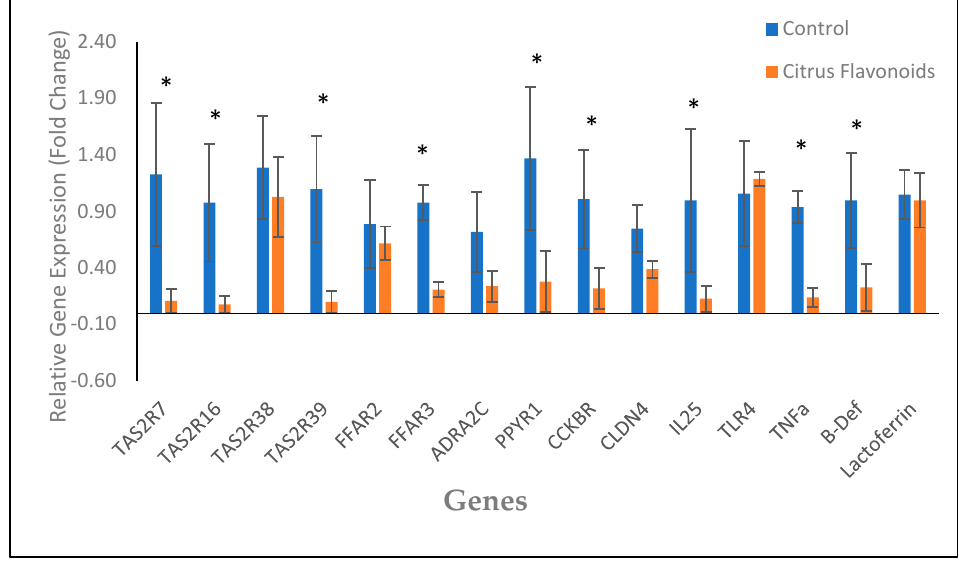
Figure 2. Gene expression in duodenum of Holstein bulls fed high-concentrate diets with or without citrus flavonoids supplementation (* = p < 0.05). TAS2R7: bitter taste receptor 7 ; TAS2R16: bitter taste receptor 16 ; TAS2R38: bitter taste receptor 38 ; TAS2R39: bitter taste receptor 39 ; FFAR2: free fatty acid receptor 3 (gpr41) ; FFAR3: free fatty acid receptor 2 (gpr43) ; ADRA2C: alpha 2 adrenergic receptors subtype C ; PPYR1: pancreatic polypeptide receptor 1 ; CCKBR: cholecystokinin receptor 4 ; IL-25: interleukin-25 ; TLR4: pattern recognition receptors, such as Toll-like receptor 4 ; TNFa: tumor necrosis factor alpha ; B-Def: beta-defensin .